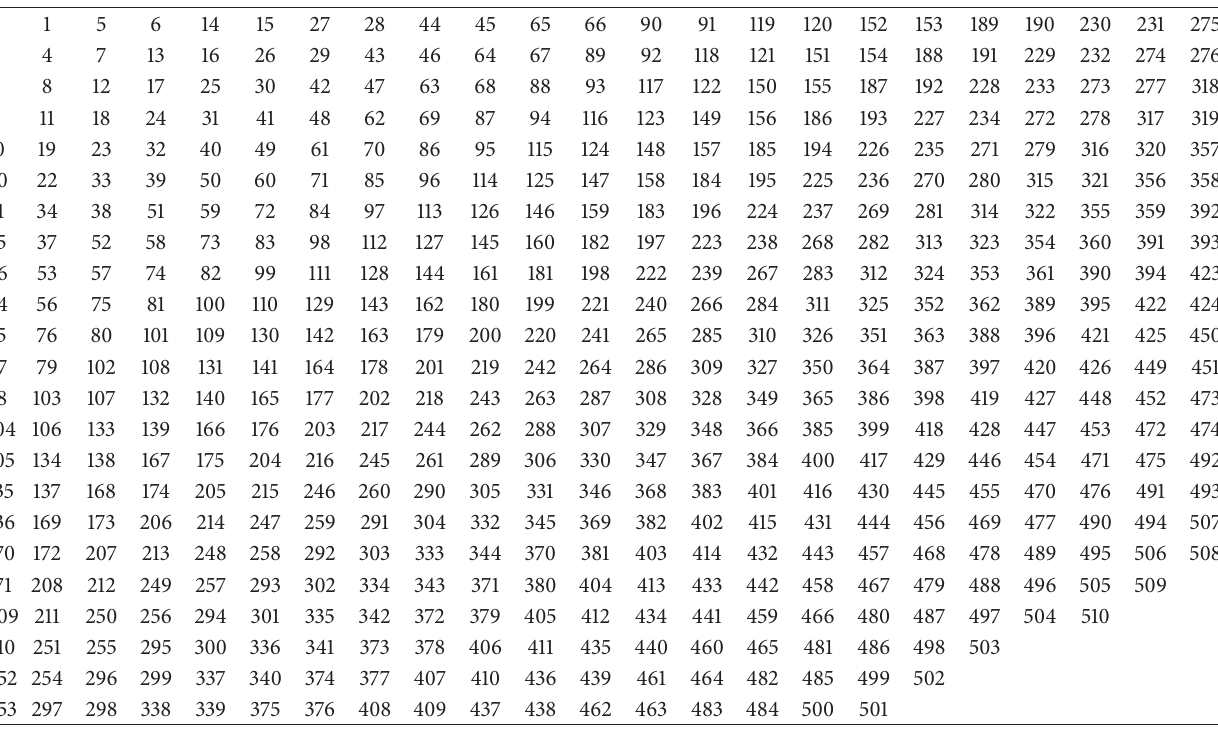
Table 1: The index of quantization value on each frequency order.